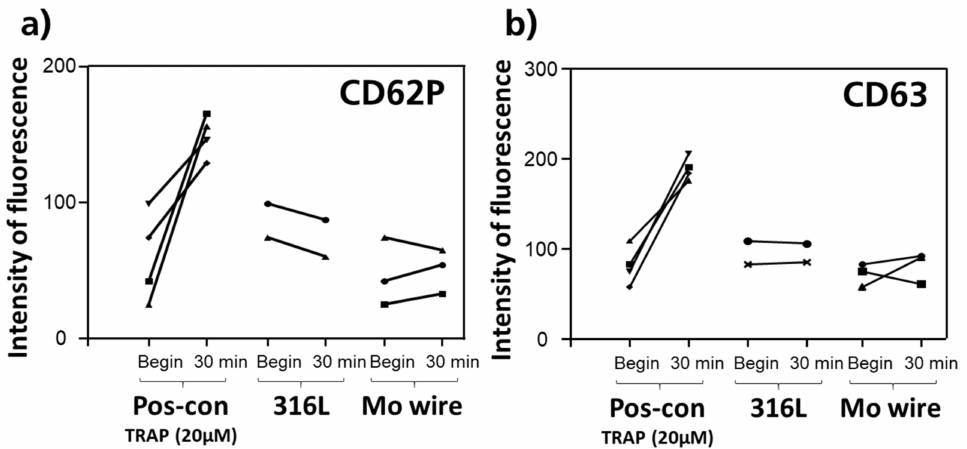
Figure 6. Thrombogenicity assay with human thrombocytes. The expression of the activation markers CD62P ( a ) and CD63 ( b ) was not triggered by a 30-min incubation with 316L wire or Mo wire. n = 2–4.